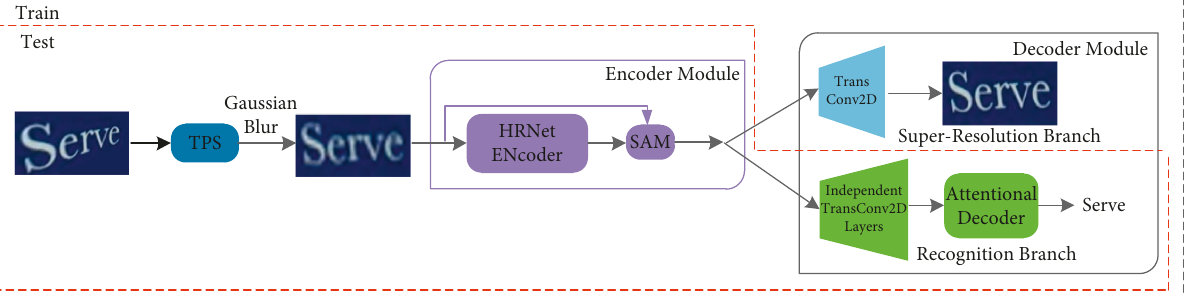
Figure 1: Structure of the proposed model.